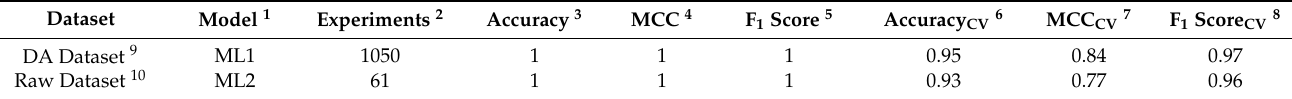
Table 2. Classification model results for M . canis with and without data augmentation.